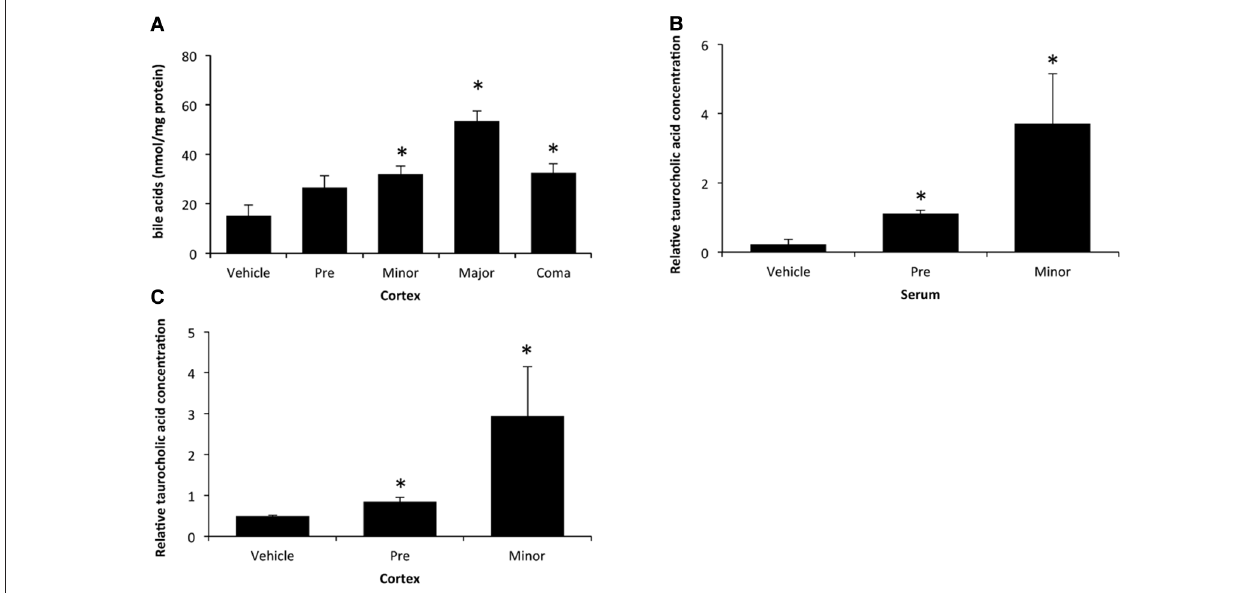
FIGURE 1 | Bile acids are elevated in the cortex during azoxymethane (AOM)-induced hepatic encephalopathy (HE). (A) Concentrations of total bile acids in cortex homogenates during the indicated stages of neurological decline in AOM-treated mice that are normalized to protein concentrations. (B) Relative concentrations of taurocholic acid (TCA) in serum from vehicle and AOM-treated mice at the pre-neurological and minor neurological stages of AOM-induced HE. (C) Relative concentrations of TCA in cortex homogenates normalized by weight in vehicle and AOM-treated mice at the pre-neurological and minor neurological stages of AOM-induced HE. ∗ p < 0.05 compared to vehicle-treated mice. n = 3 for total bile acid analyses and n = 5 for the metabolic screen for TCA.